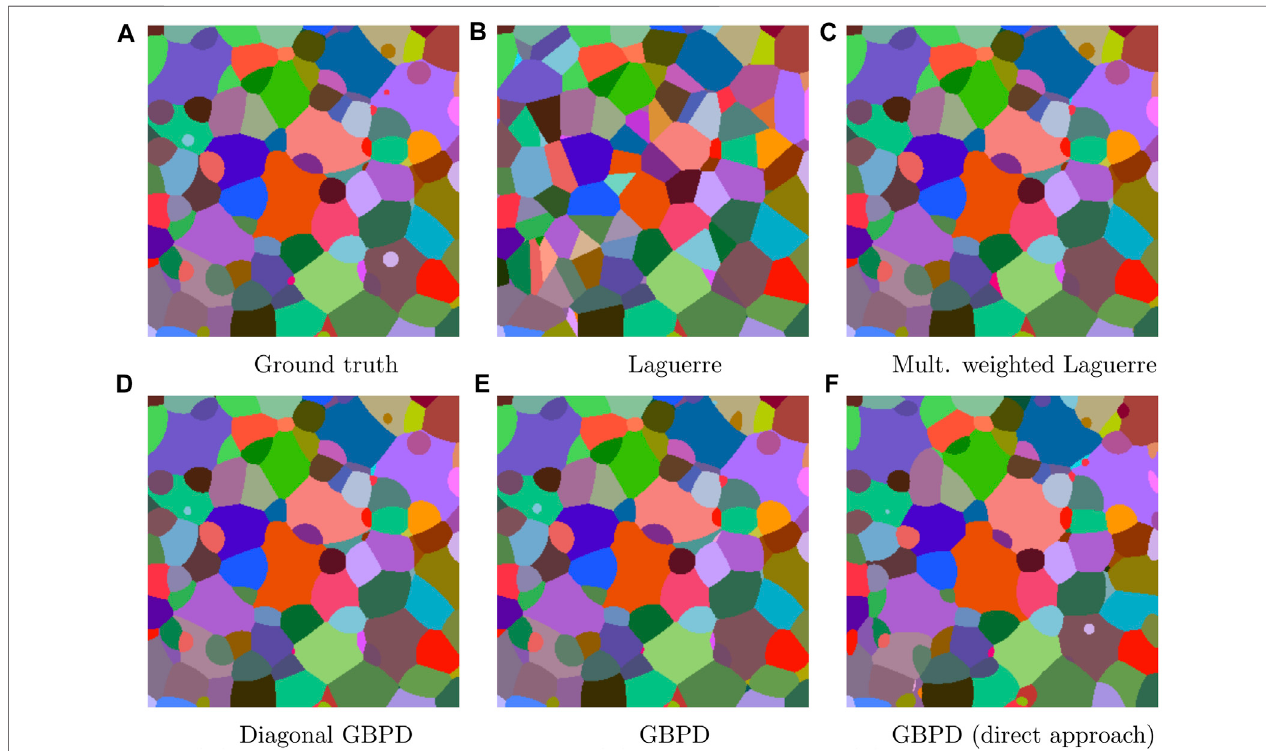
FIGURE 3 | Two-dimensional slices through (A) the simulated ground truth image data and the corresponding fi tted tessellations: (B) – (E) were obtained by the gradient descent-based method described in Section 2.3 , whereas (F) followed from the direct approach described in Section 2.4.2 .